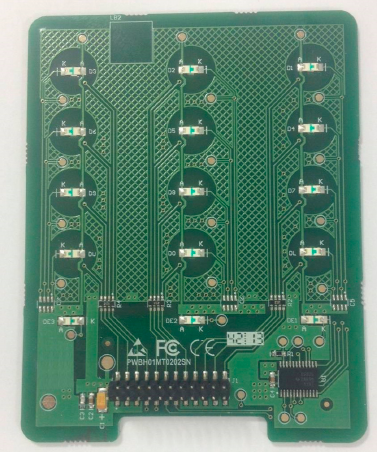
Figure 7. Touch keyboard of the base station.